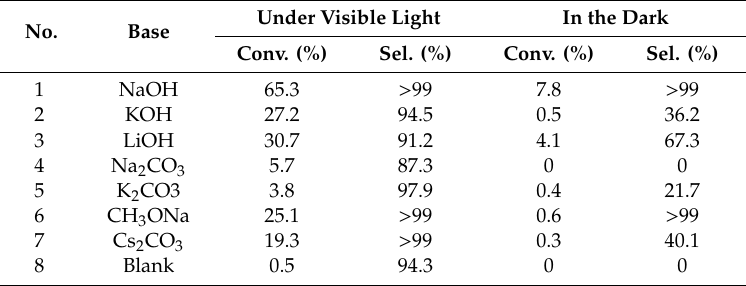
Table 5. E ff ect of the di ff erent bases on the reaction of benzyl alcohol and acetophenone. Under Visible Light In the Dark No. Base Conv. (%) Sel. (%) Conv. (%) Sel.